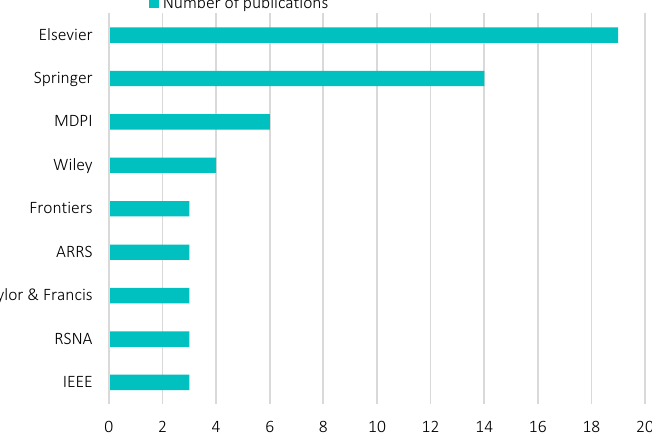
Figure 7. Analysis of most contributing publisher.